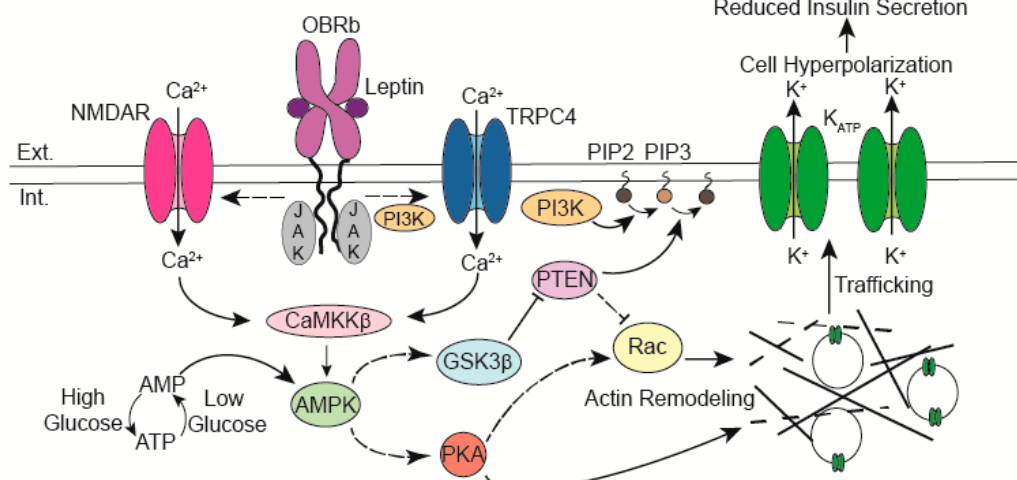
Figure 1. Leptin binding to its receptor (OBRb) leads to a calcium influx through calcium-permeant ion channels. The rise in intracellular calcium activates CaMKK β which then phosphorylates and activates AMPK. Downstream of AMPK actin remodeling is triggered through PTEN inhibition and activation of PKA. Depolymerization of the cortical actin cytoskeleton allows vesicles containing K ATP channels to traffic to the membrane. The increased abundance of K ATP channels reduces β -cell excitability thereby suppressing insulin secretion. Abbreviations: Extracellular (Ext.), Intracellular (Int.), N-methyl-D-Aspartate Receptor (NMDAR), Calcium (Ca 2+ ), Janus Kinase (JAK), Ca 2+ /calmodulin kinase kinase β (CaMKK β ), AMP-activated protein kinase (AMPK), Leptin receptor (OBRb), phosphoinositide 3-kinase (PI3K), phosphatidylinositol (4,5)-bisphosphate (PIP2), phosphatidylinositol (3,4,5)-trisphosphate (PIP3), phosphatase and tensin homolog (PTEN), Glycogen synthase kinase 3 β (GSK3 β ), cAMP-dependent protein kinase A (PKA), Transient receptor potential channel 4 (TRPC4), Potassium (K + ).